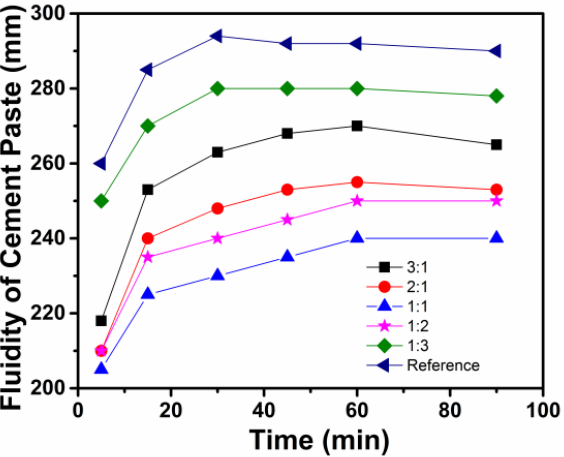
Figure 1. Effect of charge density of AMPS–DMAA copolymers on the fluidity of cement pastes.